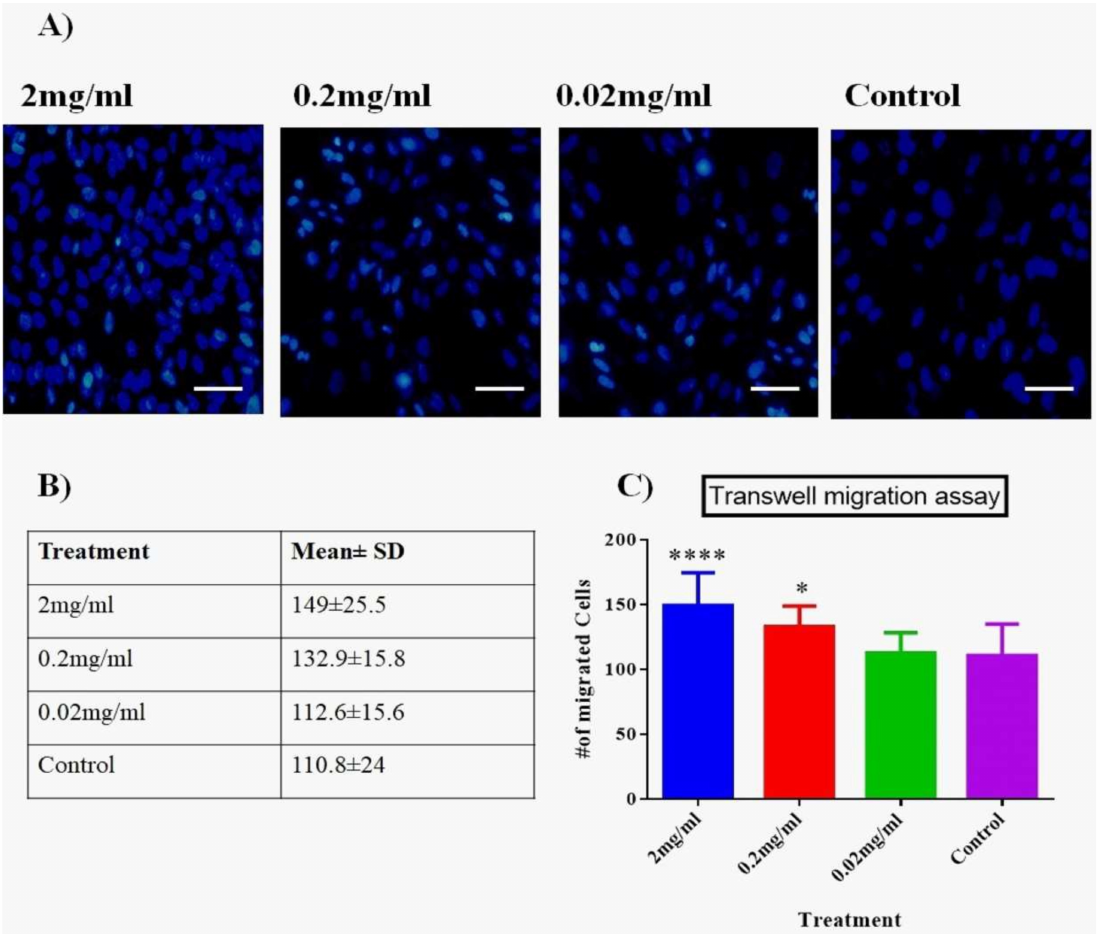
Figure 3. Two-chamber Transwell system. ( A ) Evaluation of migration potential using two-chamber Transwell system of hPDLSCs treated with media containing di ff erent concentrations of Biodentine ™ and controls (magnification 200 × ). ( B ) A representative table of the number of migrating cells among all treated group. Data are shown as mean ± SD. ( C ) A statistical analysis of the migrating cells among all treated groups ( p < 0.05). (**** p < 0.00005, * p <